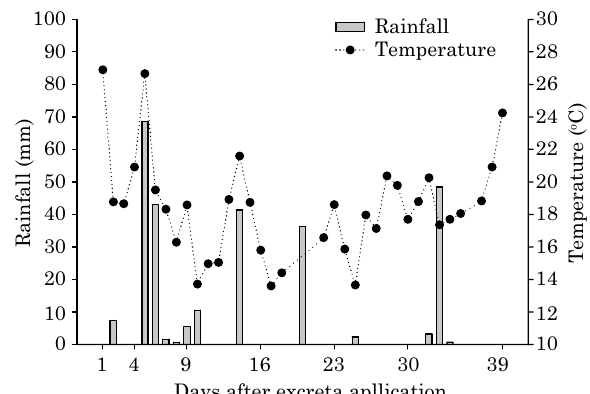
figure 1. daily rainfall and mean daily temperature at the study site over the 39-day trial (Sept. 1 to oct. 10, 2009) in an Argissolo Vermelho Distrófico típico (typic Paleudult).